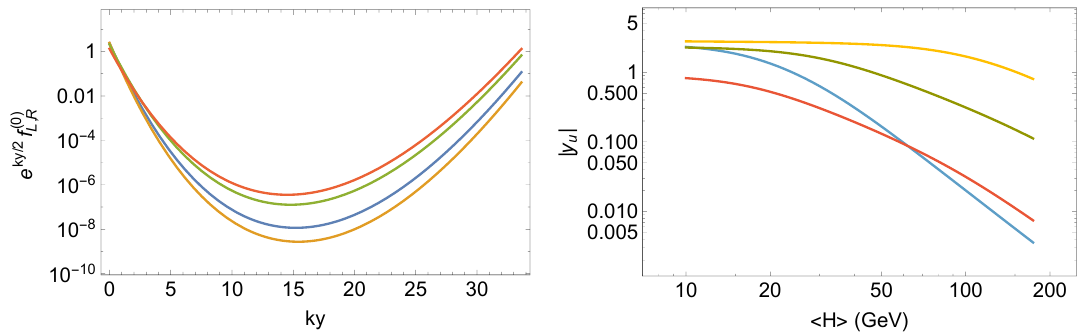
Figure 7 . (a) Pro(cid:12)le along the extra dimension of the left- and right-handed charm (blue and yellow), and the left- and right-handed top (green and red). (b) Yukawa couplings charm (blue), y u of the top (yellow) and the o(cid:11)-diagonal Yukawa couplings j j 33 y u j j 32